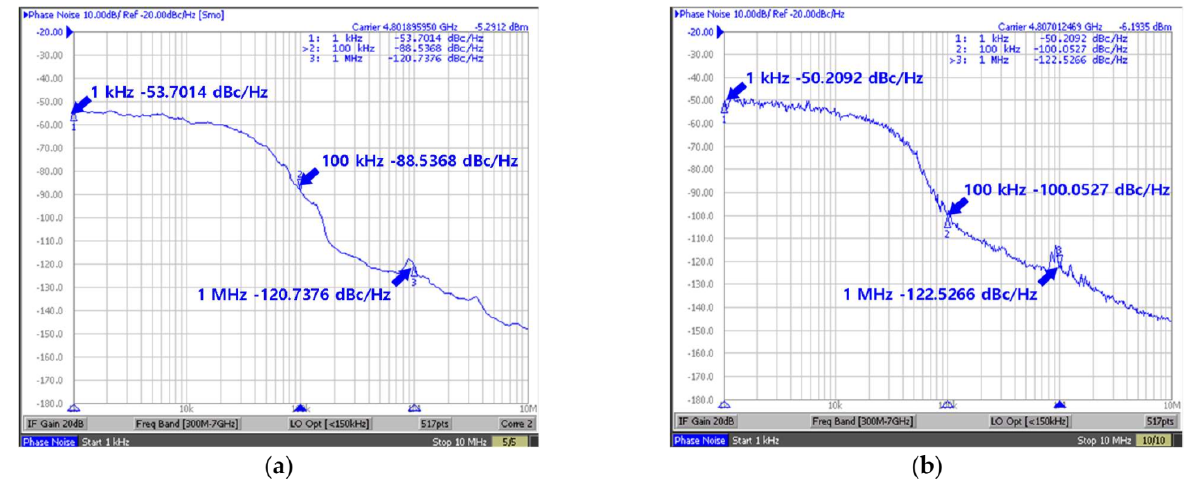
Figure 10. Output noise measurement result of the proposed VCO at 4.8 GHz ( a ) without switched dc-dc converter, and ( b ) with switched dc-dc converter.